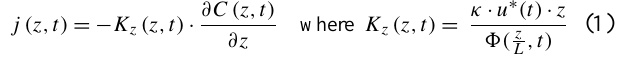
Fig. 2. HONO emission rate in the altitude interval between 0.1–1m due to traffic in the model.